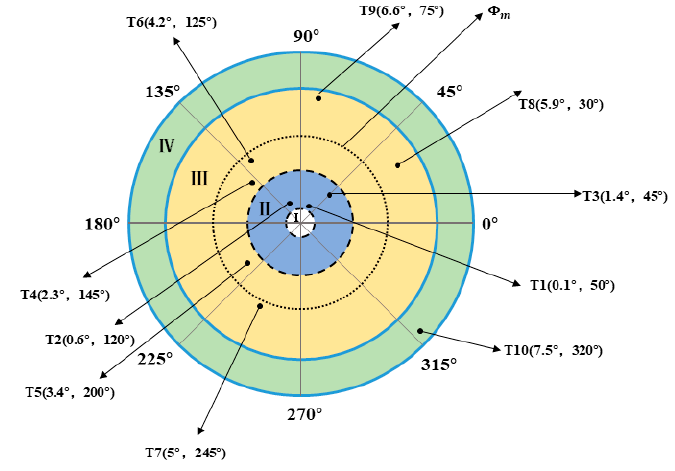
8 of 17 Figure 6. IBCLT control model diagram of the Risley prism system. The simulation system is made up of eight modules. Module 1 is the simulation time. Module 2 is the target position. The Φ is the elevation angle and Θ is azimuth angle of target. Module 3 is the inverse solution of the Risley prism system. The